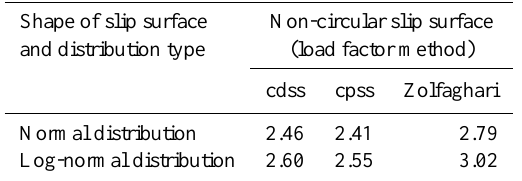
Table 12. Summary of reliability indices for the problem in Fig. 15. Shape of slip